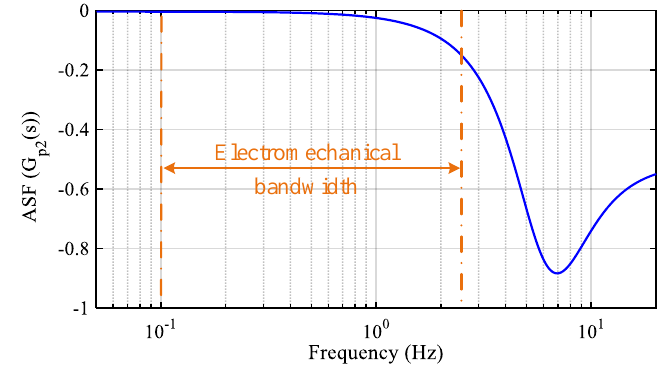
Figure 6. ASF of G p 2 ( s ) with respect to U ref .